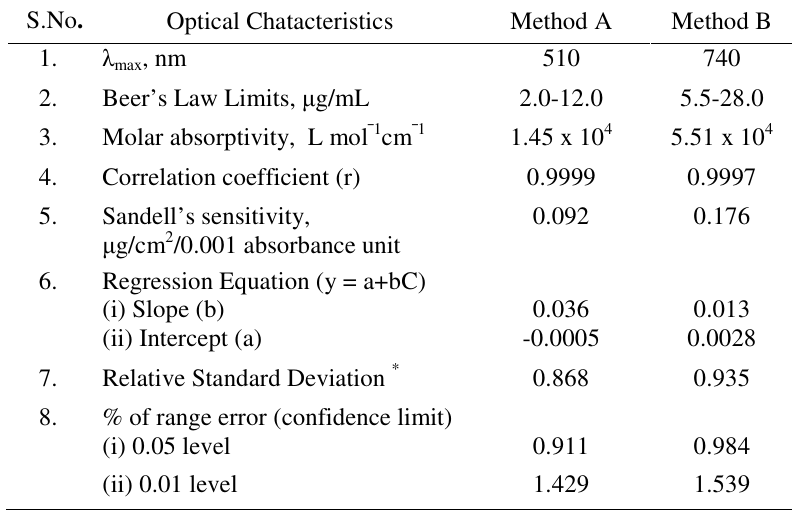
Table 1 . Optical characteristics, precision, accuracy of the methods proposed in the determination of